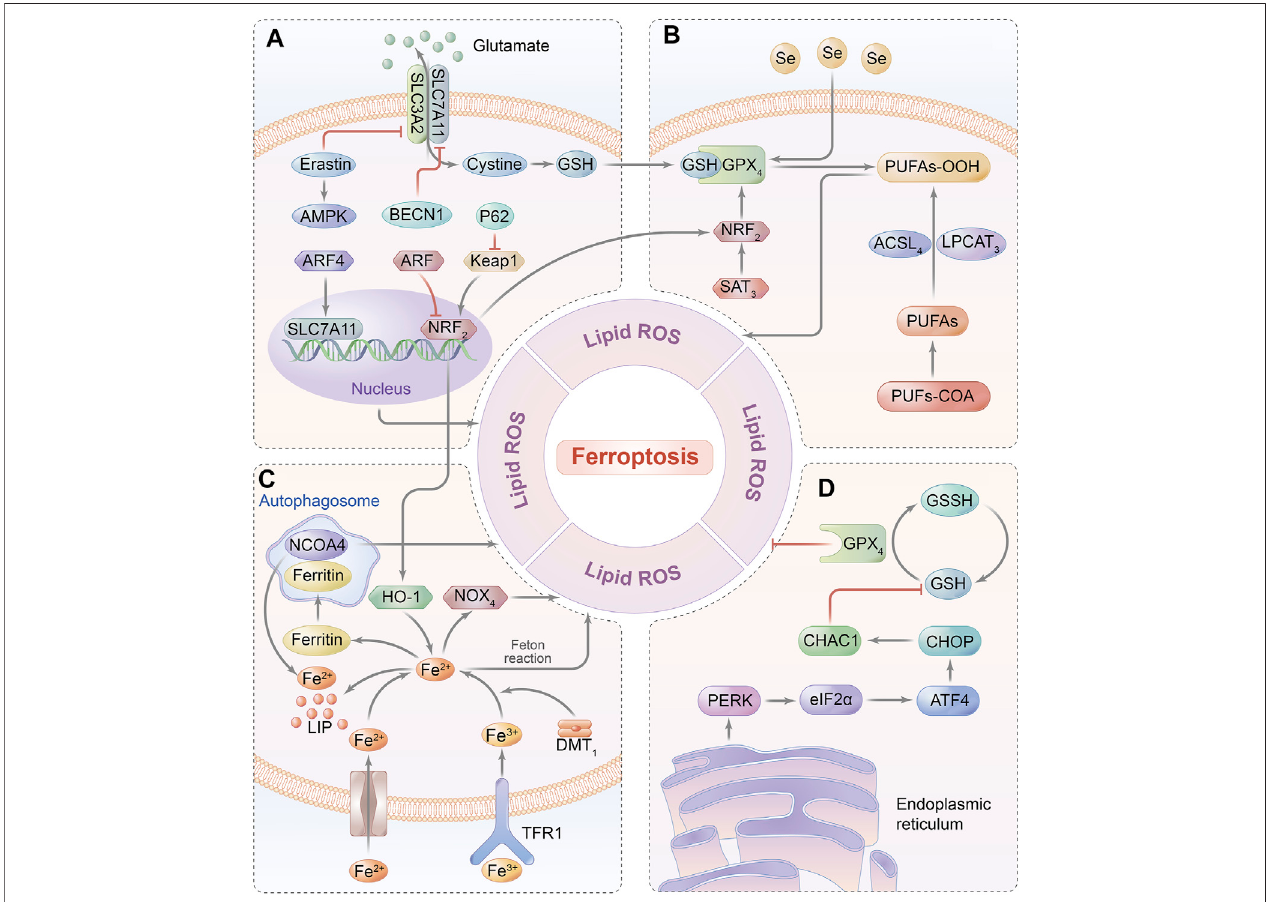
FIGURE 3 | Ferroptosis-related signaling pathway. (A) GSH relies on the molecular substrate called cysteine, which is transferred via a heterodimeric cell membrane antiporter, system Xc-that iscomposed of SLC7A11 and SLC3A2, regulating ferroptosis by exchanging glutamate and cystine at a 1:1 ratio. (B) Ferroptosis is triggered by the peroxidation of PUFAs and accumulation of ROS, which are catalyzed by ACSL4 and LPCAT3. GPX4 can hydrolyze lipid peroxides into innocuous alcohols. (C) Free iron bound with Tf is transported into intracellular area via TfR1 in endosomes. Fe (III) is reduced to redox-active iron (FeII) by ferrireductase of STEAP3, while Fe (II) is released from endosomes into LIP through DMT1. Under the oxidative stress, Fe 2+ catalyzes the generation of hydroxyl radicals by Fenton reaction,whicheventuallyinitiatesferroptosis.FerritinisutilizedtoironstorageandcanbedegradedbyNCOA4-mediatedferritinophagy. (D) GSHsynthesisisarequisite for GPX4inmediatinganantioxidantimpact,therebyinhibiting theiron-dependentROSproduction bycatalyzing lipid hydroperoxidesintolipidalcohols.;Abbreviations: GPX4, glutathione peroxidase 4; PUFAs, poly-unsaturated fatty acids; NCOA4, nuclear receptor coactivator 4; GSH, glutathione; SLC7A11: solute carrier family 7 member 11; SLC3A2, solute carrier family 3member 2; ACSL4, acyl-coA synthetase long-chain family member 4;LPCAT3. lysophosphatidylcholine acyl-transferase 3; Tf, transferrin; TfR1, transferrin receptor 1; ATF4, activating transcription factor 4; and CHOP, C/EBP homologous protein.